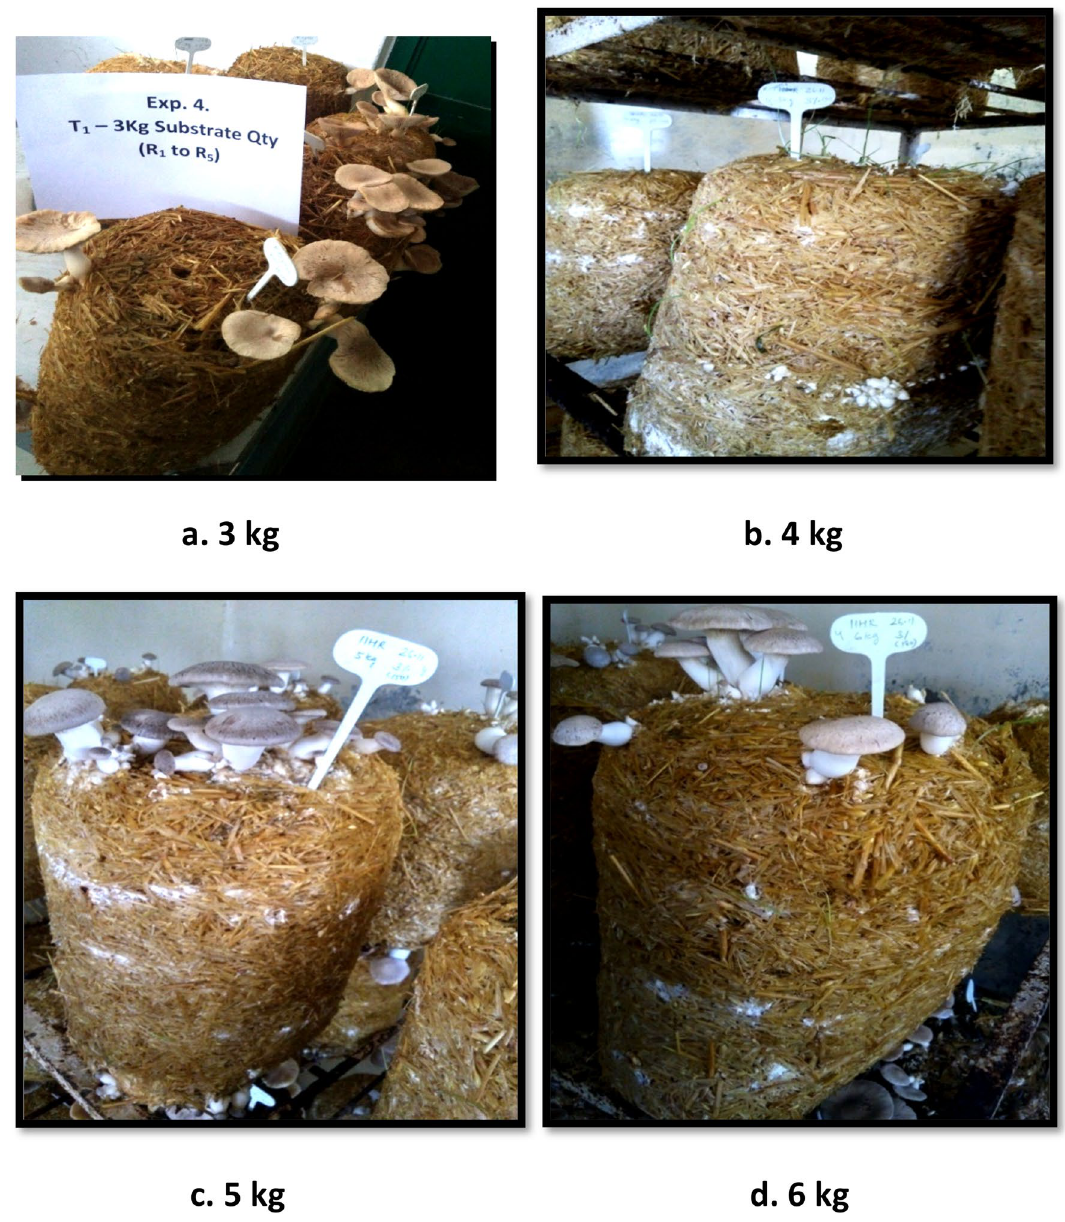
Figure 9. Photographs of different quantities of substrate for P. eryngii production.